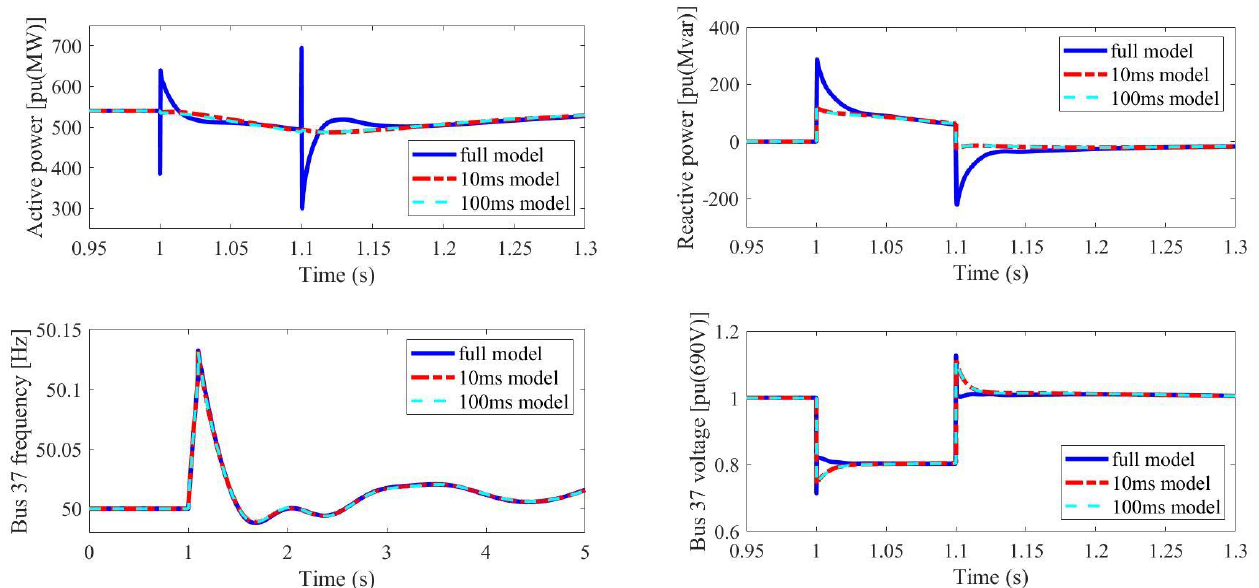
Figure 11. New England 39-bus system, Scenario 1: Grid fault.